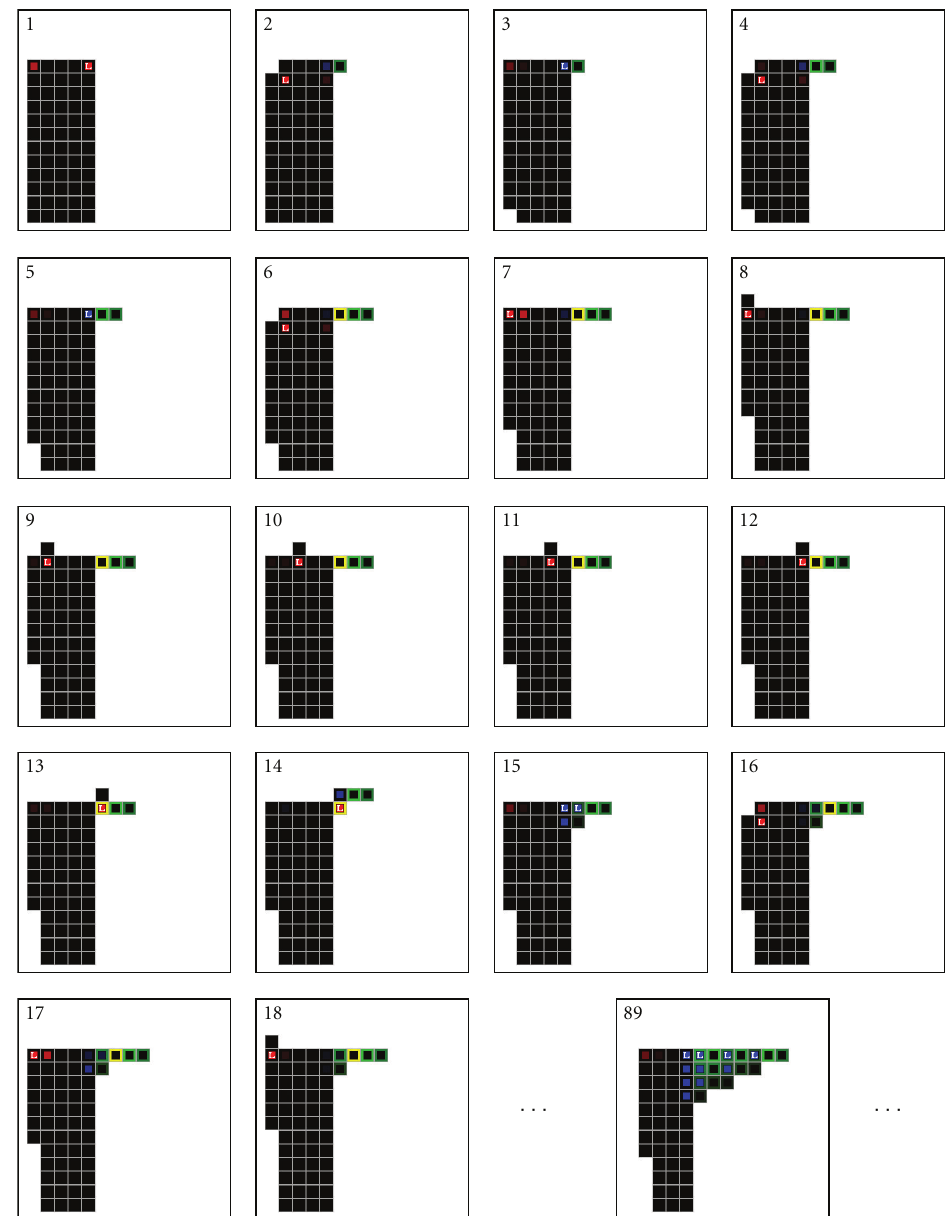
Figure 15: Simulation result of adaptive cantilever construction from 12 × 5 rectangle